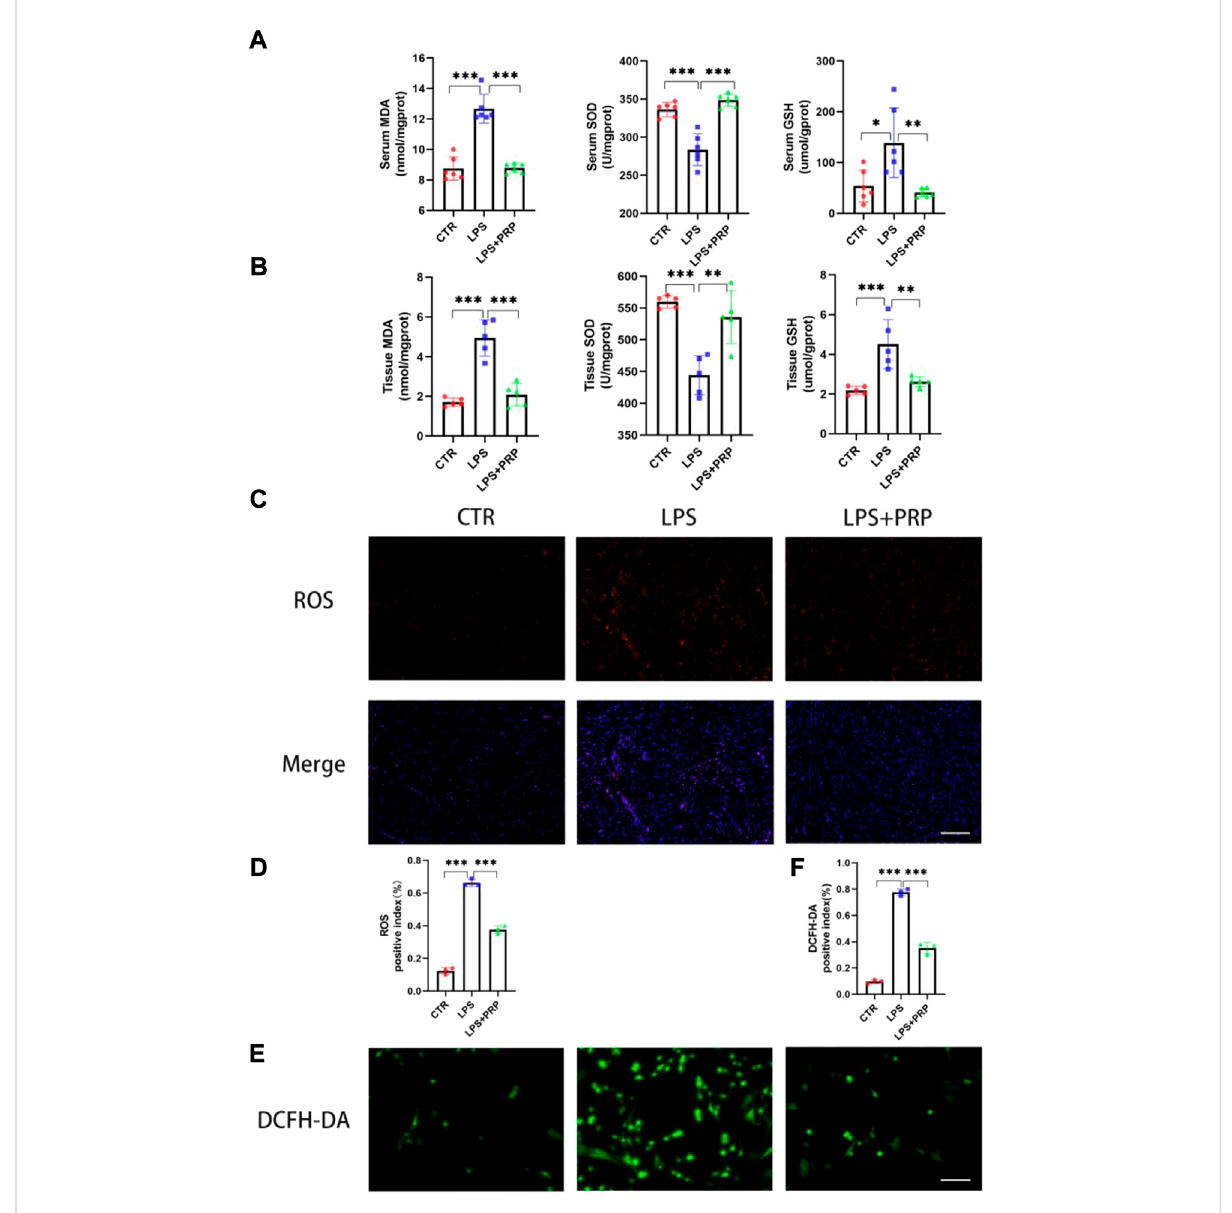
PRP attenuated LPS-induced oxidative stress and lipid peroxidation in vivo . (A) Effects of LPS on the levels of MDA, SOD, and GSH in serum ( n = 6). (B) The levels of MDA, SOD, and GSH in tissues after LPS and PRP treatment ( n = 5). (C – D) Effect of LPS on ROS levels in heart tissues ( n = 3, scale bar = 20 µm). (E) and ( F) Effect of LPS on cellular ROS levels in NRCMs ( n = 3, scale bar = 20 µm). * indicates p < 0.05. ** indicates p < 0.01. *** indicates p <